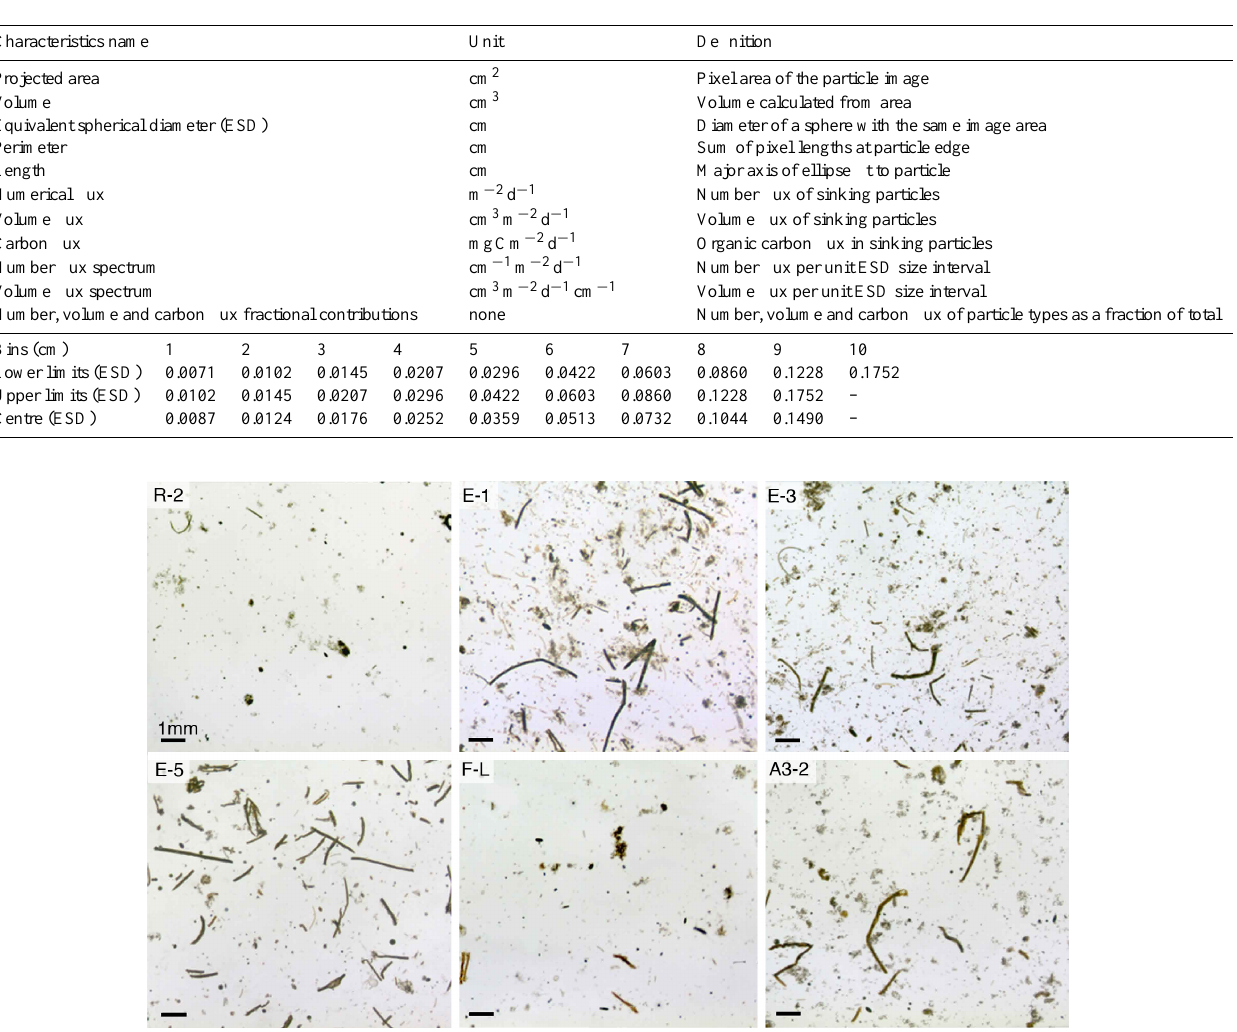
Figure 5. Images of sinking particles embedded in polyacrylamide gels, collected at each site at 210m. Comparison of images suggests differences in terms of particles abundance and nature at each